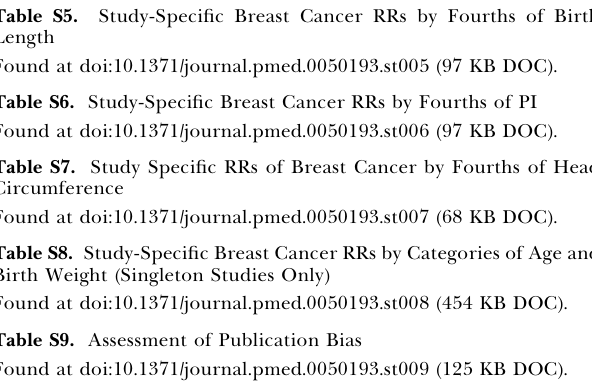
Table S4. Study-Specific Breast Cancer RRs by Categories of Birth Weight Found at doi:10.1371/journal.pmed.0050193.st004 (249 KB DOC). Table S5. Study-Specific Breast Cancer RRs by Fourths of Birth Length Found at doi:10.1371/journal.pmed.0050193.st005 (97 KB DOC). Table S6. Study-Specific Breast Cancer RRs by Fourths of PI Found at doi:10.1371/journal.pmed.0050193.st006 (97 KB DOC). Table S7. Study Specific RRs of Breast Cancer by Fourths of Head Circumference Found at doi:10.1371/journal.pmed.0050193.st007 (68 KB DOC). Table S8. Study-Specific Breast Cancer RRs by Categories of Age and Birth Weight (Singleton Studies Only) Found at doi:10.1371/journal.pmed.0050193.st008 (454 KB DOC). Table S9. Assessment of Publication Bias Found at doi:10.1371/journal.pmed.0050193.st009 (125 KB